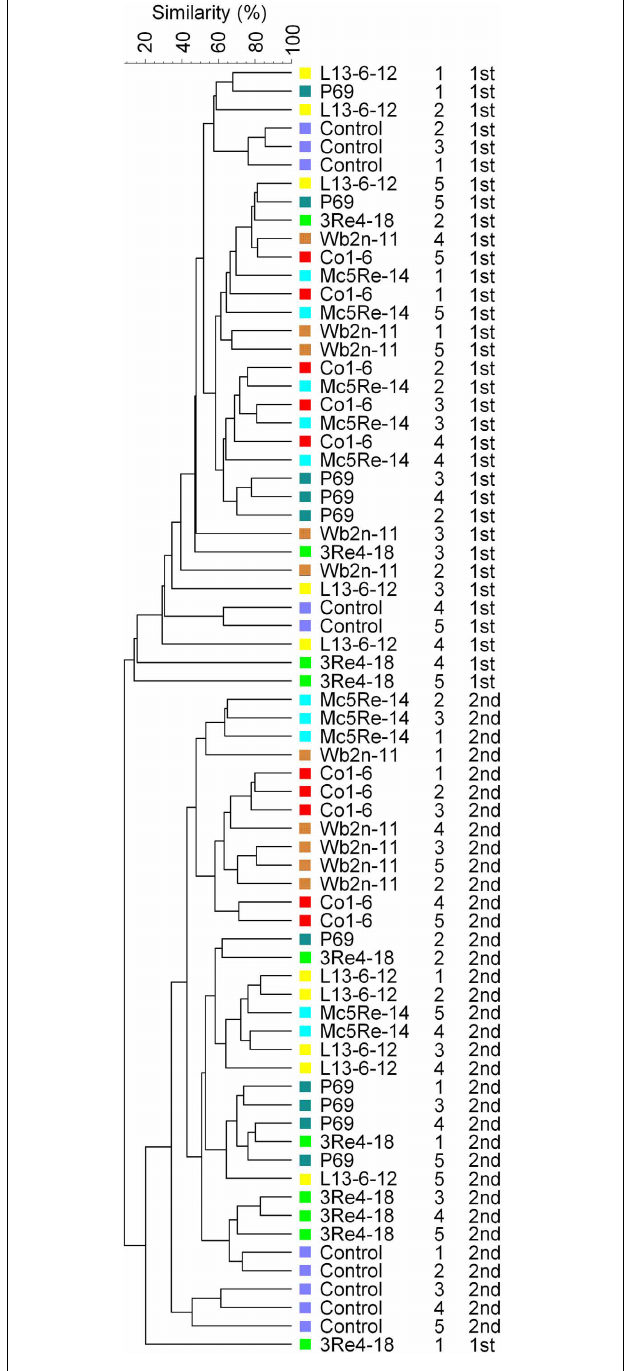
FIGURE 2 | Cluster analysis of eubacterial community fingerprints. Similarities between SSCP fingerprints were calculated using the curve-based Pearson correlation coefficient and grouped according to their similarity using the hierarchical UPGMA. Treatments ( Streptomyces subrutilus Wb2n-11, Bacillus subtilis Co1-6, Paenibacillus polymyxa Mc5Re-14, Pseudomonas fluorescens L13-6-12, Stenotrophomonas rhizophila P69, Serratia plymuthica 3Re4-18, and water control) and sampling times (1st) after 4 weeks and (2nd) after 8 weeks are indicated. Numbers 1–5 mark the five independent replicates per